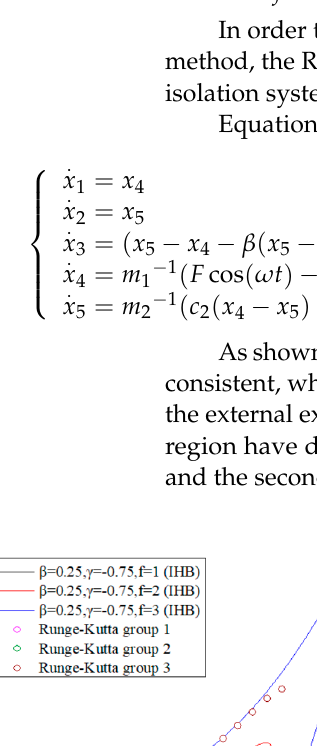
Figure 6. Amplitude–frequency characteristic curves of the isolation structures with different damping ratios (when ξ = 0.05, 0.10.3, β = 0.25, γ = − 0.75) ( a , b ) Amplitude–frequency characteristic curve of the substructure; ( c , d ) Amplitude–frequency characteristic curve of the superstructure; ( e , f ) Amplitude–frequency characteristic curve of the hysteretic element.